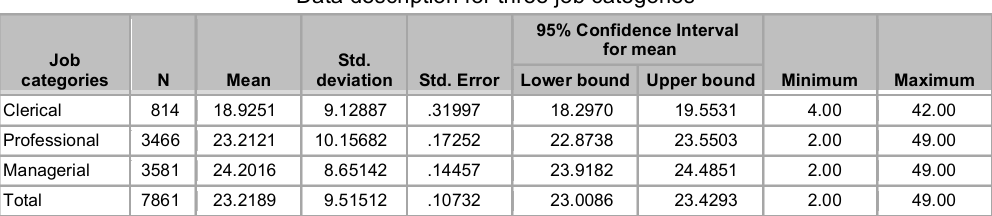
Data description for three job categories